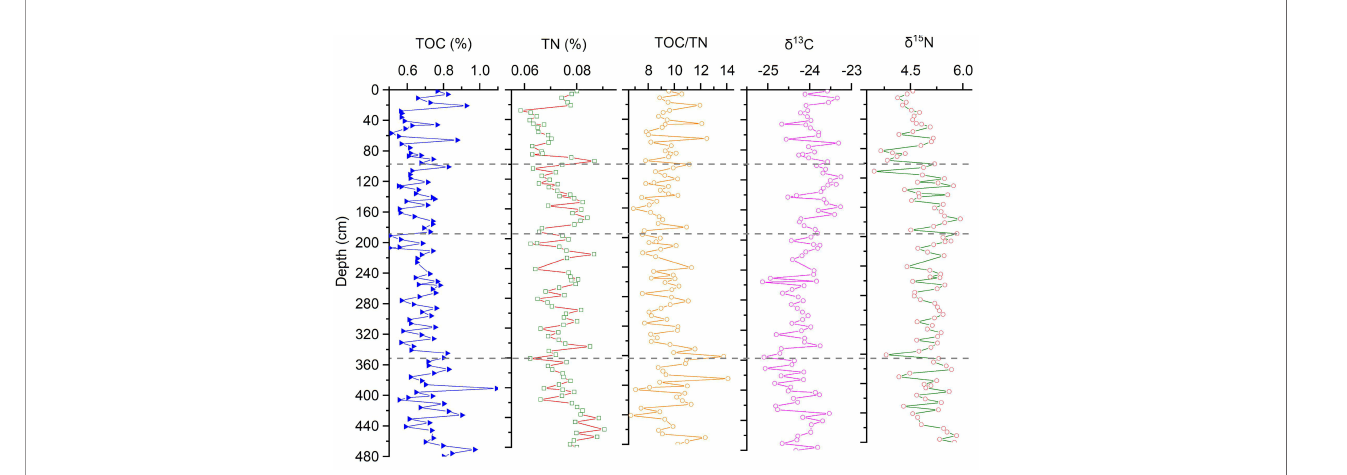
FIGURE 3 | Pro fi les of TOC, TN, TOC/TN, d 13C, and d 15N in core C2. Dashed lines mark evolutionary stage divisions as discussed in Section 4.2.